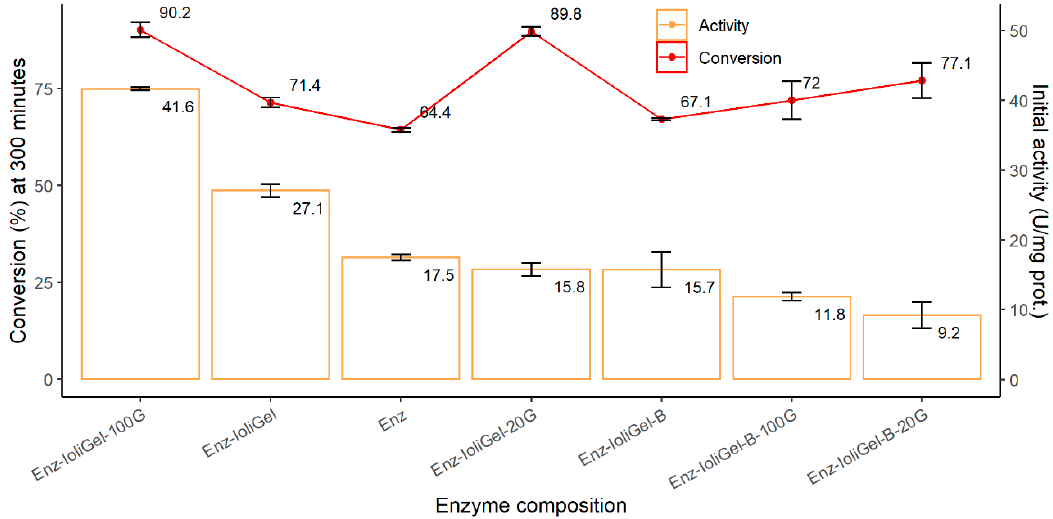
Figure 5. Activity and conversion exhibited by CaLB during butyl butyrate synthesis using different immobilized CaLB (ionogel) and free enzyme at 70 °C.